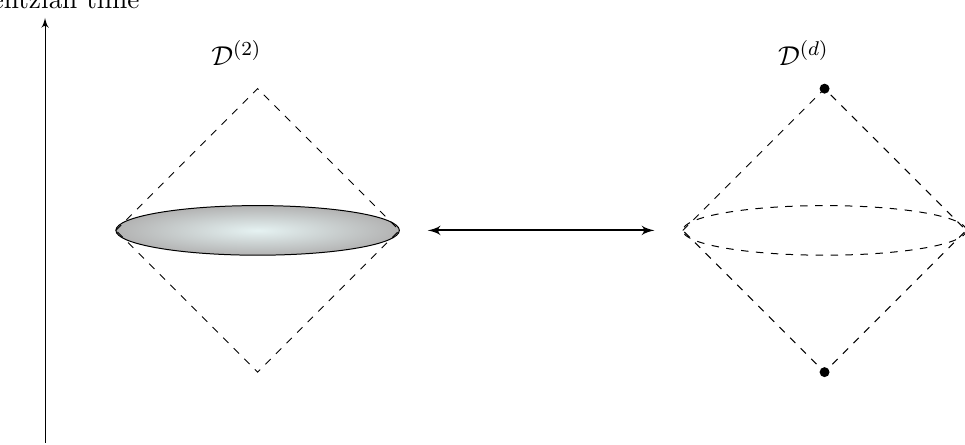
Figure 3 . The defect duality between a codimension-two defect and a codimension- d defect when d =